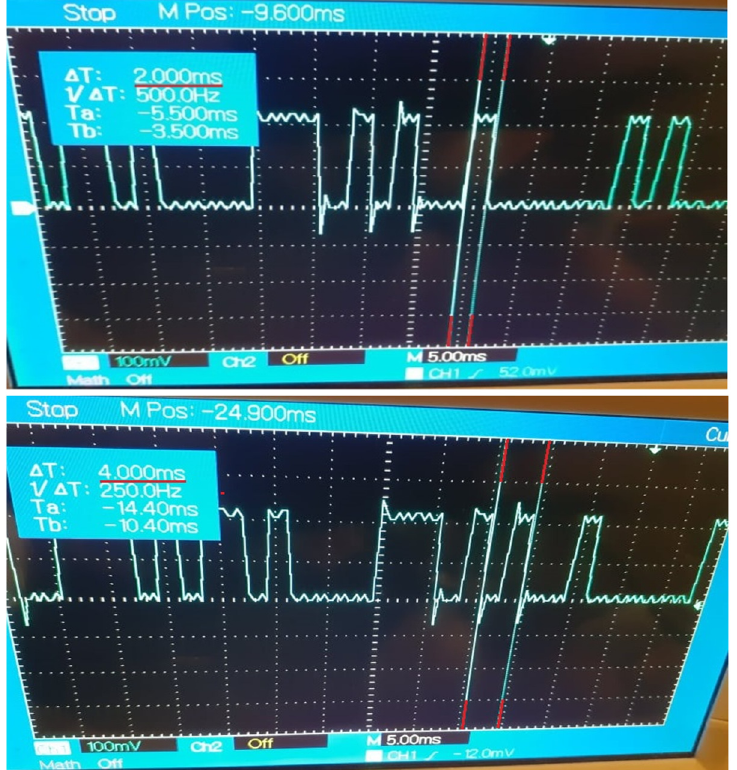
Figure 8. Generated Digital Signal based on payload delivered by the Gateway Application at 2 ms recurrence.